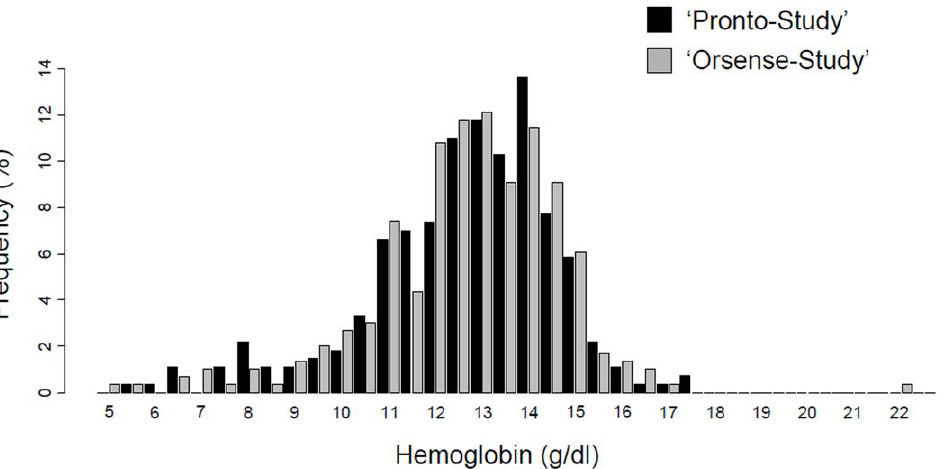
Figure 2. Distribution of hemoglobin value in the two populations studied. As depicted in the figure, the overlap of hemoglobin values between the two populations studied is almost complete all along the range of hemoglobin values.